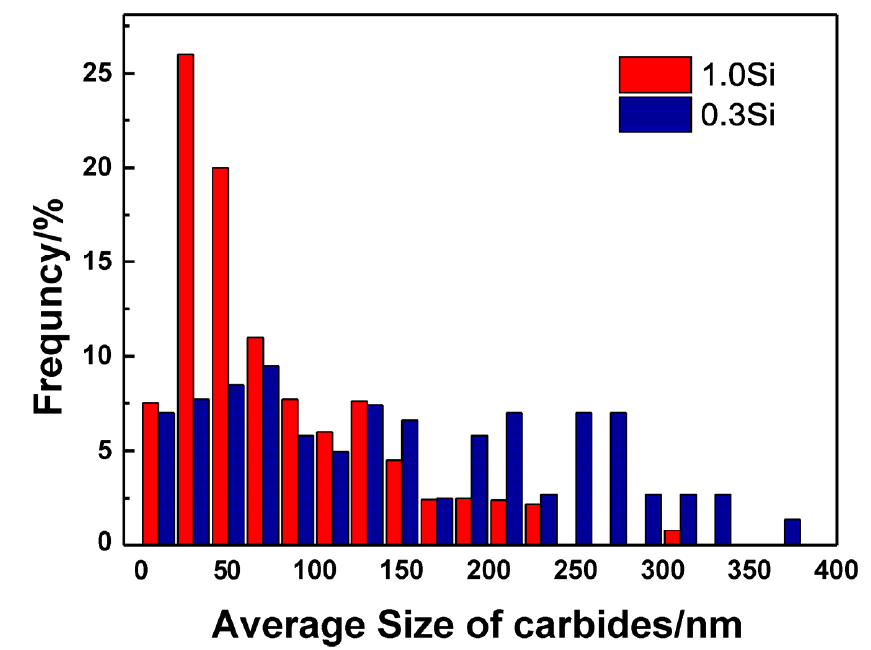
Figure 10. Average particle size distribution of tested steels. Table 2. Carbide size, percentage and type for tested steels tempered for 64 h at 650 °C.